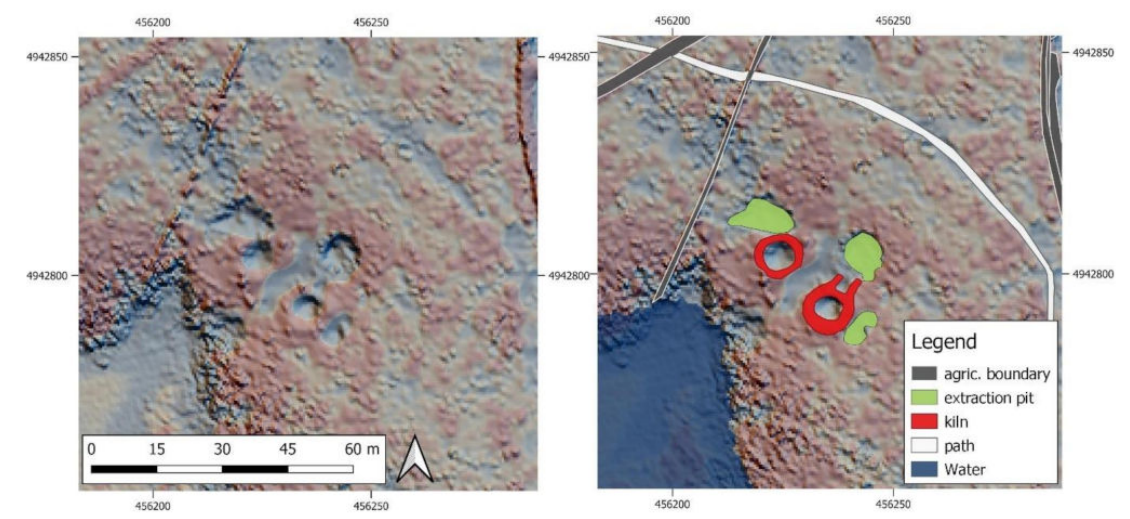
Figure 32. A group of pits interpreted as lime kilns and extraction pits (visualization: slope and MH (DFM filtered with “dense_veg” setting) combined with LRM(20) (DFM filtered with “stone_wall”